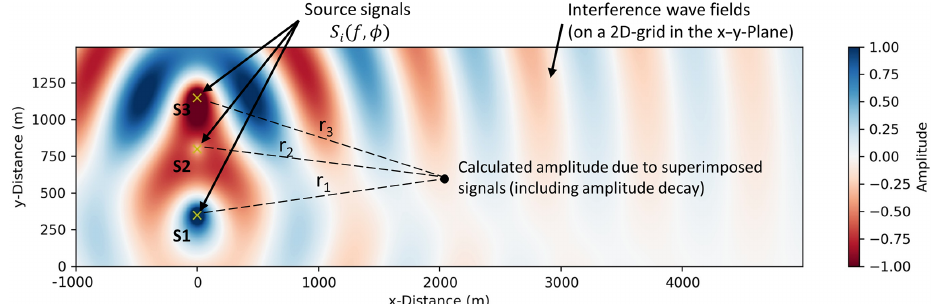
Figure 7. Schematic figure of the analytical modeling approach. Amplitudes as functions of time are calculated at points ( x , y ).